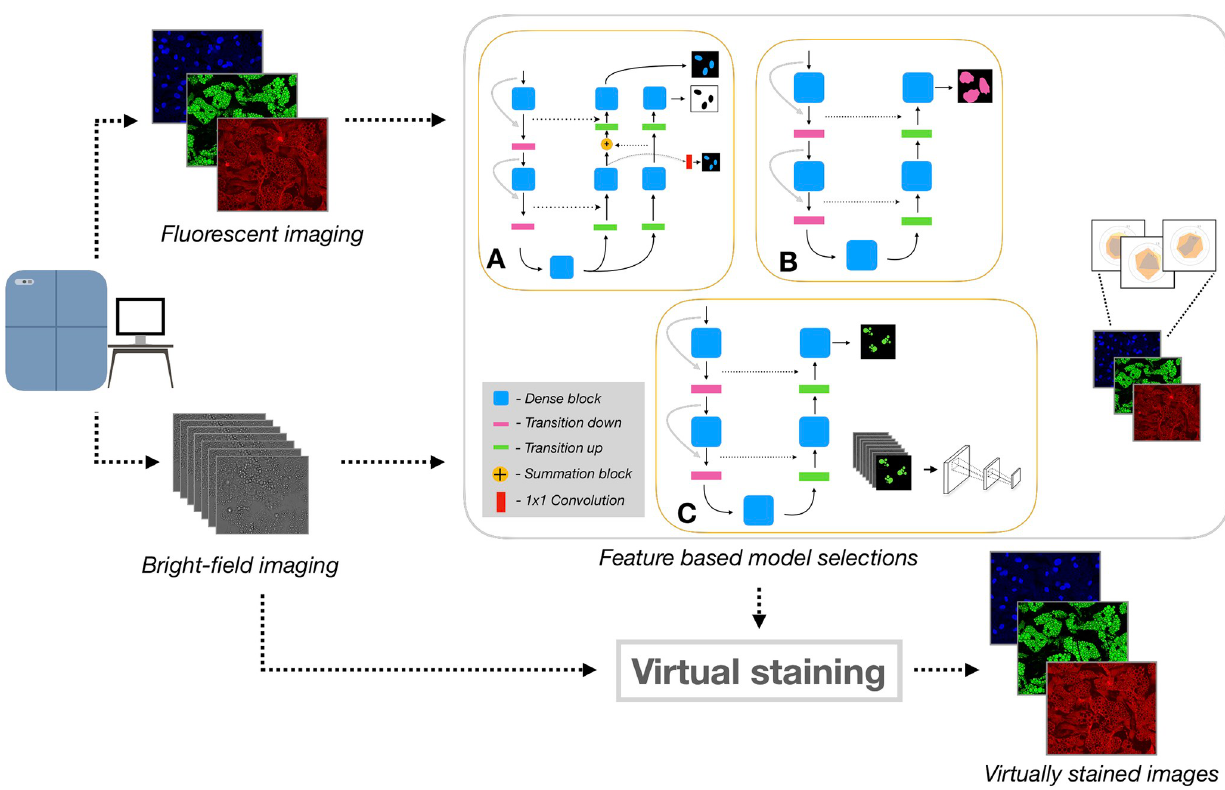
Fig 1. Proposed method and workflow. Cell cultures are imaged by fluorescence and bright-field imaging. These images are used to train and compare specialized models for generating each stain, based on biologically relevant features. The selected models are then used to virtually stain bright-field images. A. Nuclear virtual staining model which simultaneously learns the nuclear segmentation (the privileged information model, the outer-most decoder path) and the generated image for the nuclear channel (the inner-most decoder path), B. Virtual staining model for the cytoplasm and C. Virtual staining model for lipid droplets, the model utilizes a patch-level discriminator, used for adversarial